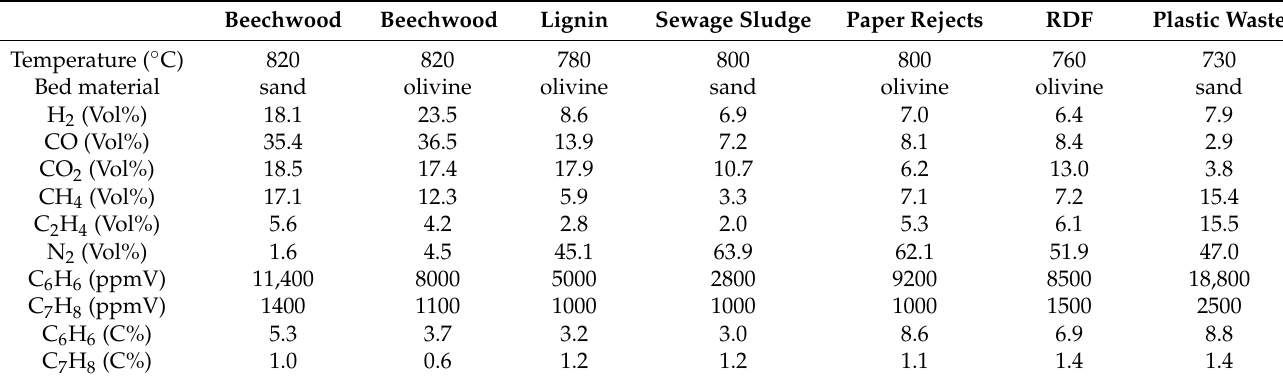
Table 4. Averaged product gas composition from the different feedstocks on a dry and tar-free basis. Beechwood Beechwood Lignin Sewage Sludge Paper Rejects RDF Plastic